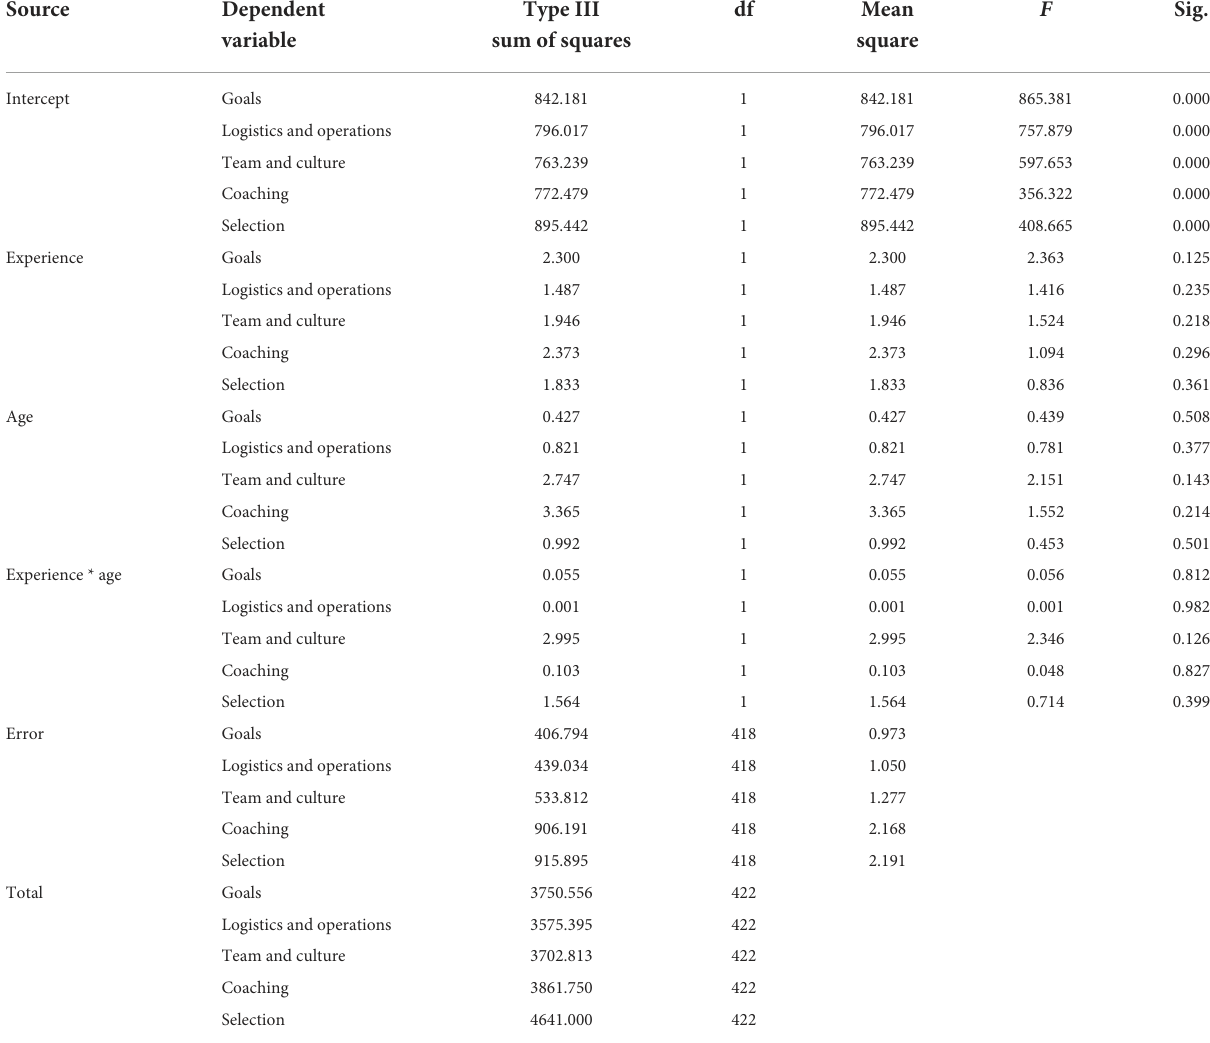
TABLE 3 Test of between-subject effects for players on the contribution of age and years of experience on organizational stressors.